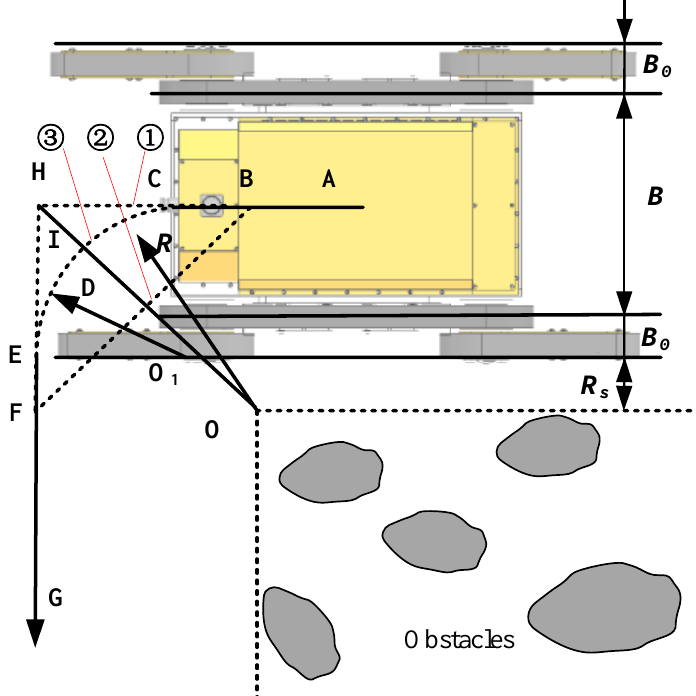
Figure 7. Principle analysis of robot steering.